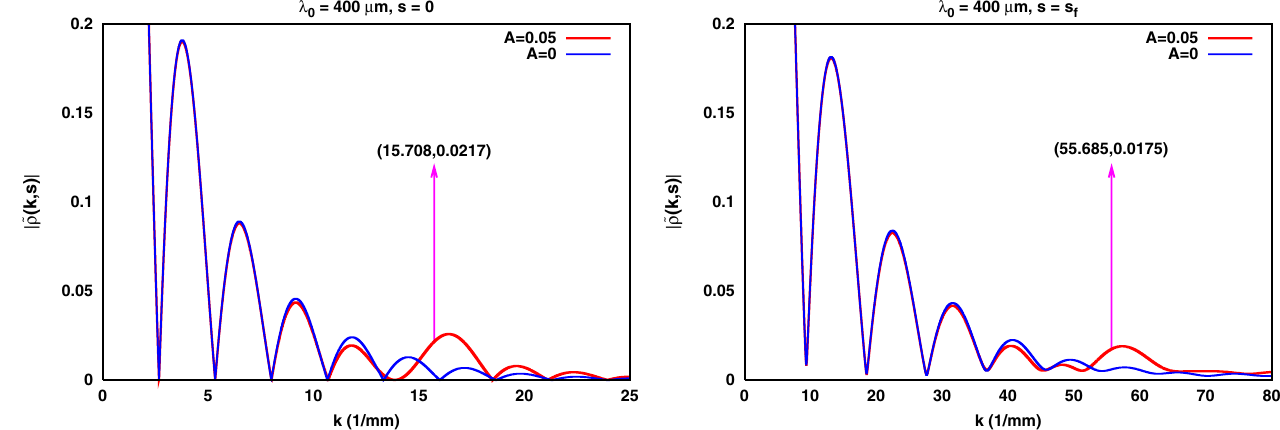
¼ 400 (cid:4) m with and without perturbation at s ¼ 0 (left) and s ¼ s 0